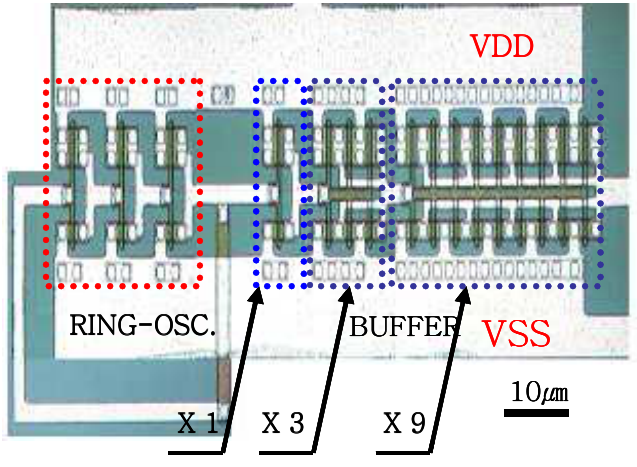
Figure 4. Fabricated 3-stages CMOS VCOs for carrier signal